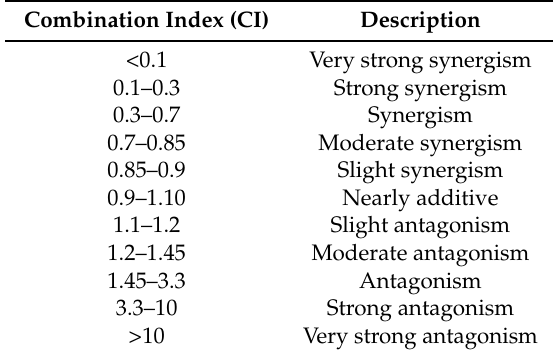
Table 4. CI ranges and their descriptions using the Chou-Talalay method